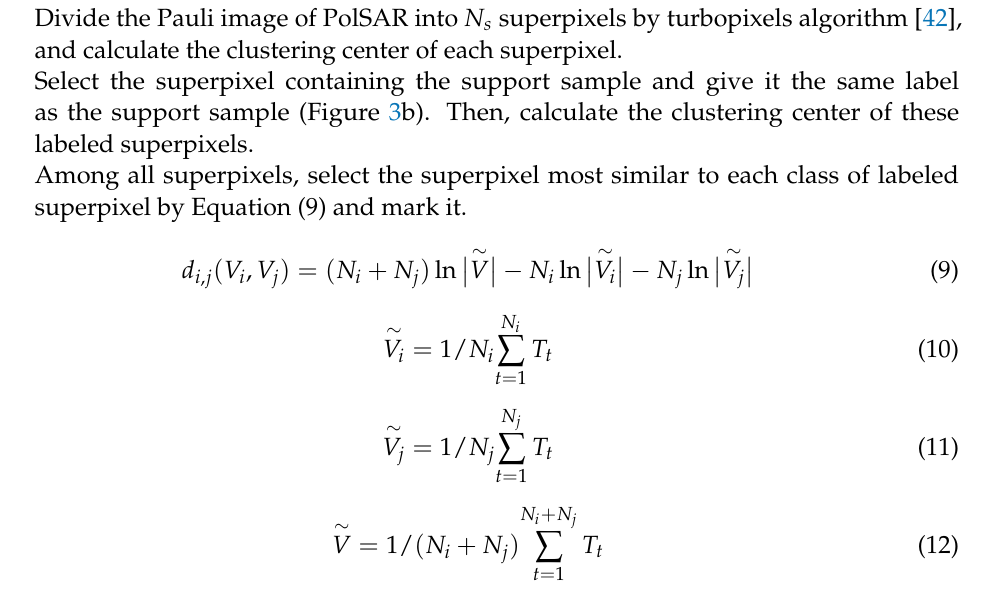
Figure 3. The flowchart of constructing training samples. ( a ) denotes the labeled samples; ( b ) denotes the labeled superpixels; ( c ) denotes the similar labeled superpixels; ( d ) denotes the labeled training samples.